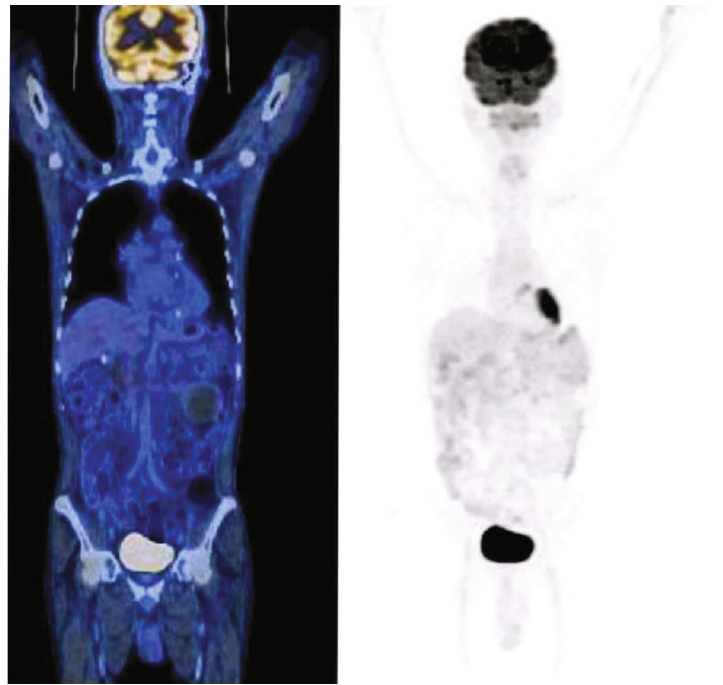
Figure 2: 18-FDG whole body PET CT showing stable disease and metabolic